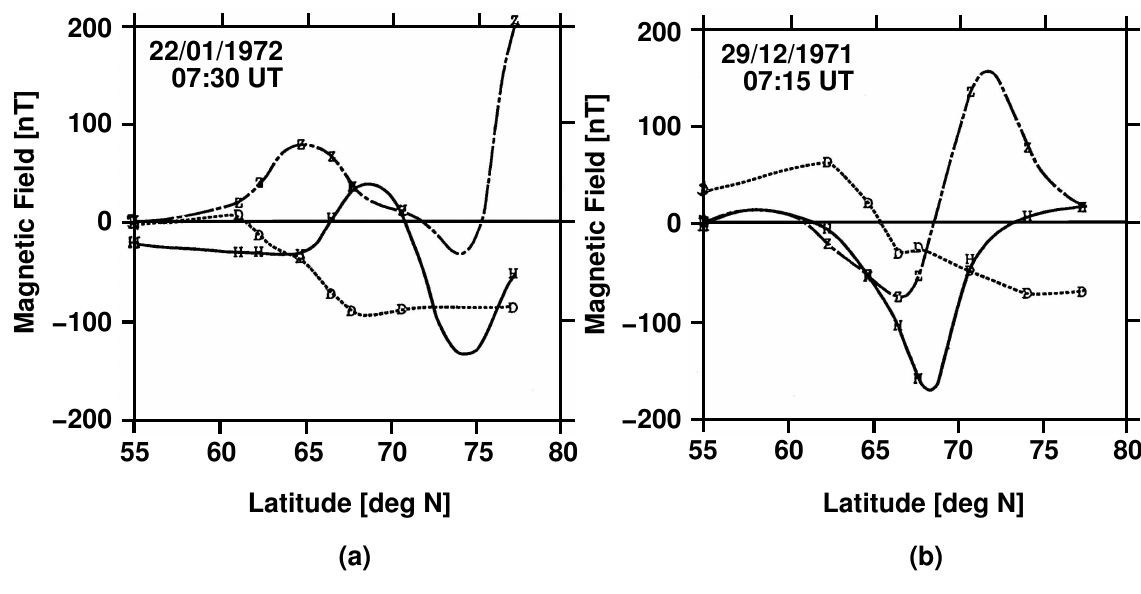
Fig. 3. (a) Latitude profile taken on the Alberta line ( ∼ 115 ◦ geographic) close to magnetic midnight. The three components of the perturba- tion magnetic field (H, D, Z) are in local magnetic coordinates. The positive Z-component across the average auroral oval latitude range is not a typical electrojet profile (which is bipolar in character) and is thought to be due to the combined edge effects of the meridional currents that are the ionospheric closure currents for the Birkeland current sheets in the morning and evening sectors. The large perturbation at the highest latitude is likely associated with the poleward border of the auroral oval, where poleward border intensifications take place. (b) Same as Fig. 3a except for a time close to midnight in which the latitude profile is representative of the morning sector westward electrojet. The asymmetric Z-component profile (large positive in the poleward region and small negative in the equatorward region) can be thought of as the combined effect of the electrojet itself (for which the positive and negative Z-component extrema should be approximately equal) and the edge effect of the morning side meridional closure current for the Birkeland